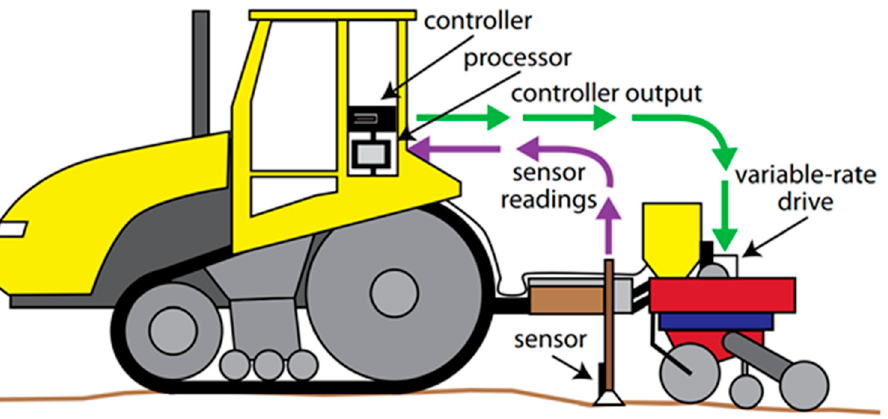
Figure 11. On-the-go soil properties sensor measurement before seeding and adjustment of seeding rate [10].